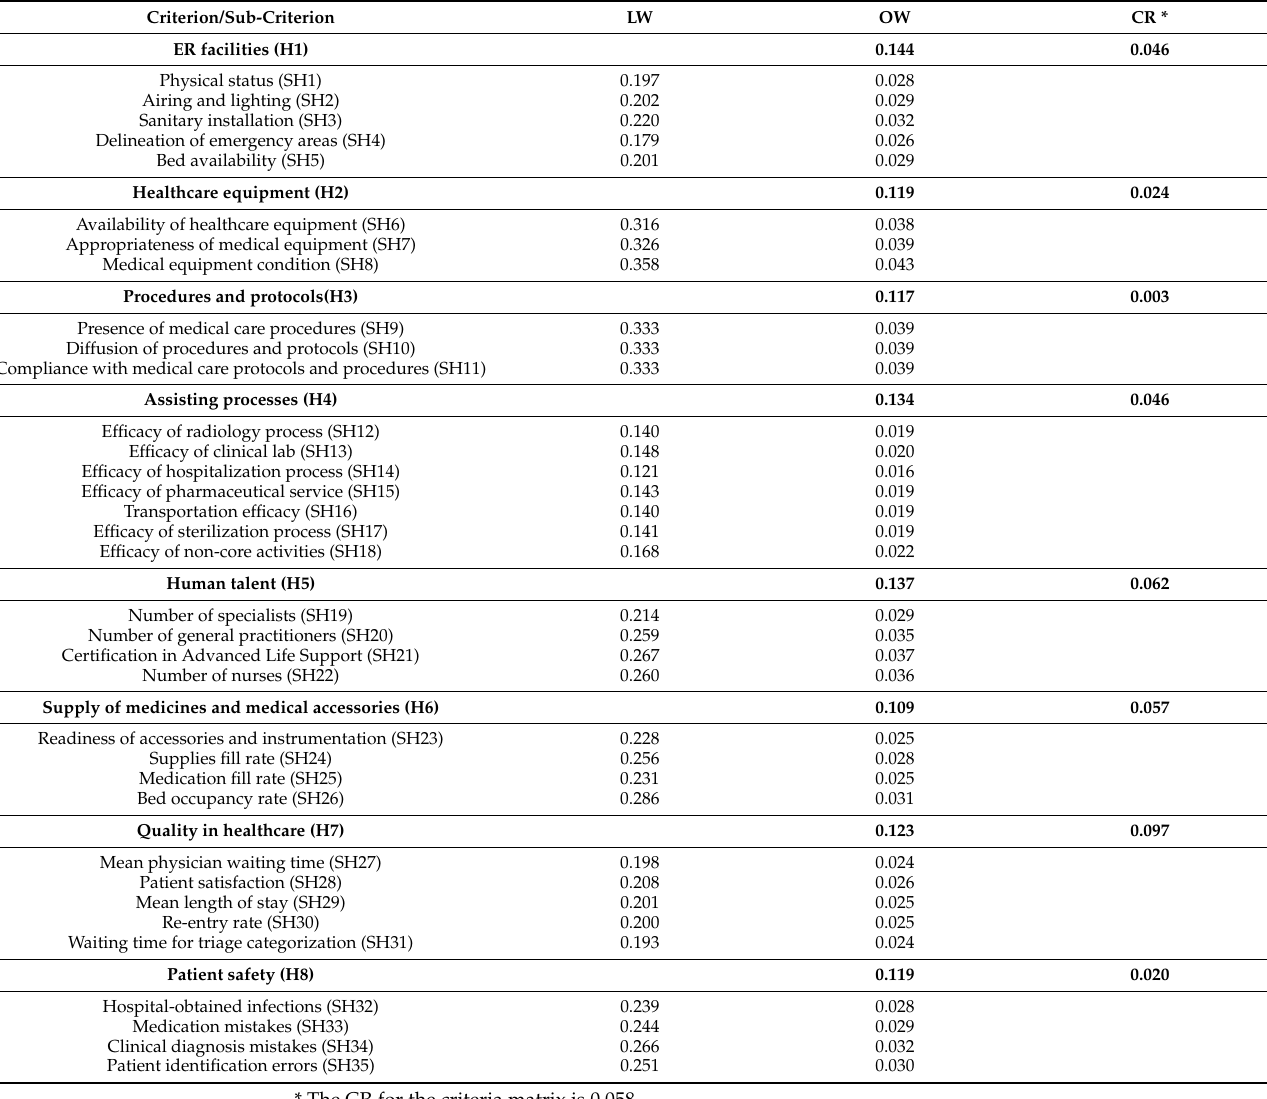
Table 4. Local weights (LW), overall weights (OW), and consistency ratios (CR) in the ED performance evaluation model.